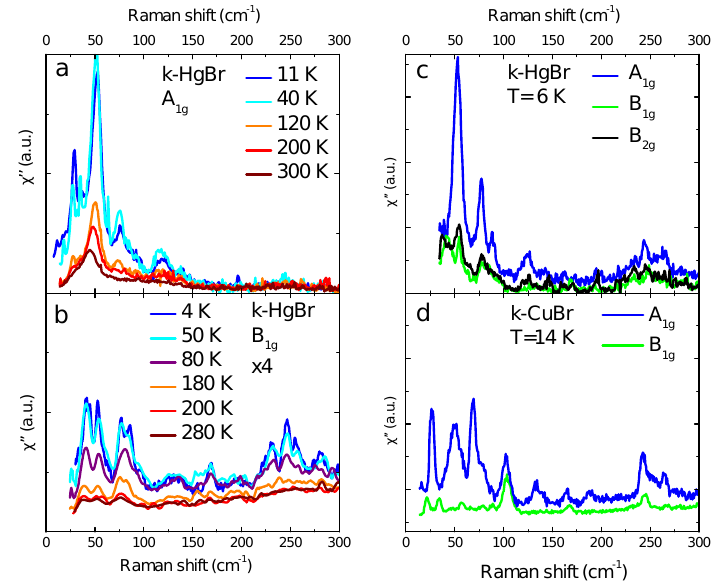
Figure 3. ( a , b ) Temperature dependence of Raman spectra of κ -(BEDT-TTF) 2 Hg(SCN) 2 Br in the range below 300 cm − 1 in ( a ) A 1 g scattering channel; and ( b ) B 1 g scattering channel, intensity is multiplied by the factor of 4; ( c ) Polarization dependence of the low-frequency spectra for κ -(BEDT-TTF) 2 Hg(SCN) 2 Br at 4 K; ( d ) Polarization dependence of low frequency spectra of κ -(BEDT-TTF) 2 Cu[N(CN) 2 ]Br at 14 K. Note the absence of the broad mode with the maximum at about 40 cm − 1